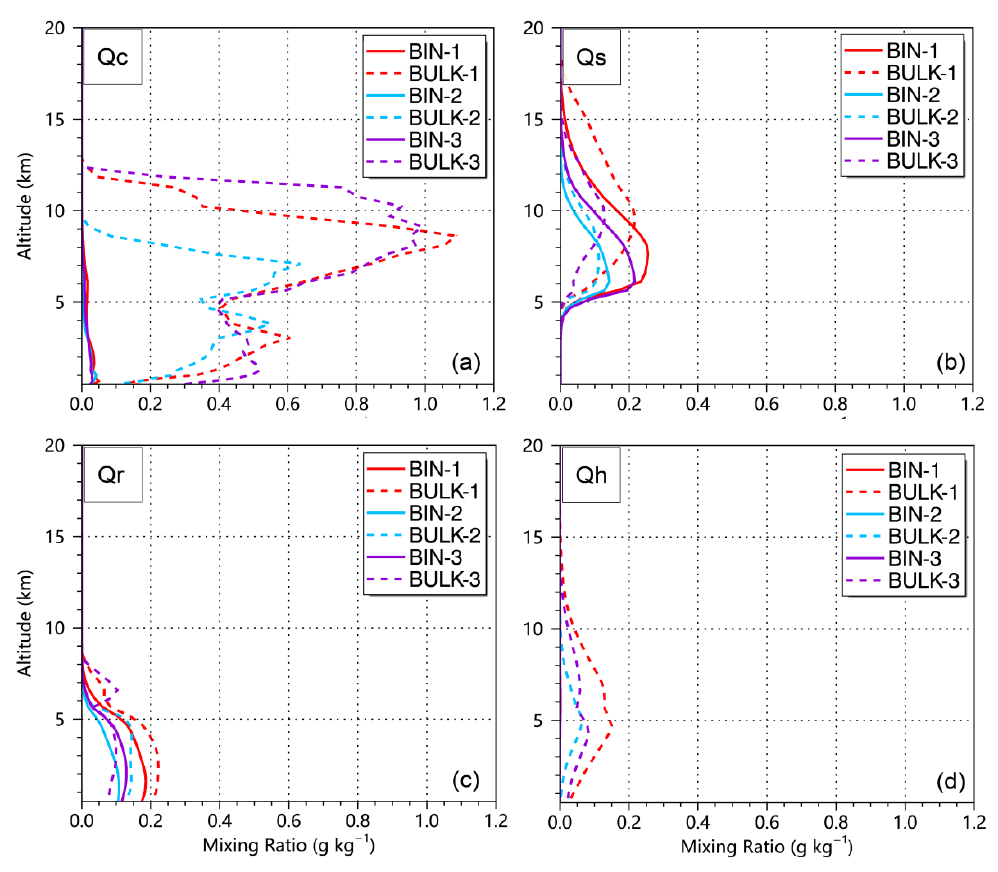
Figure 9. Domain-averaged vertical profiles of ( a ) cloud water, ( b ) snow, ( c ) rainwater, and ( d ) hail mixing ratio (g kg −1 ) during three different periods of typhoon landfall. The symbol Qx (x = c, s, r, h) represents the mixing ratio of each hydrometeor species, and the appending digits -1, -2, and -3 in the legend represent the periods before, during, and after landfall, respectively.